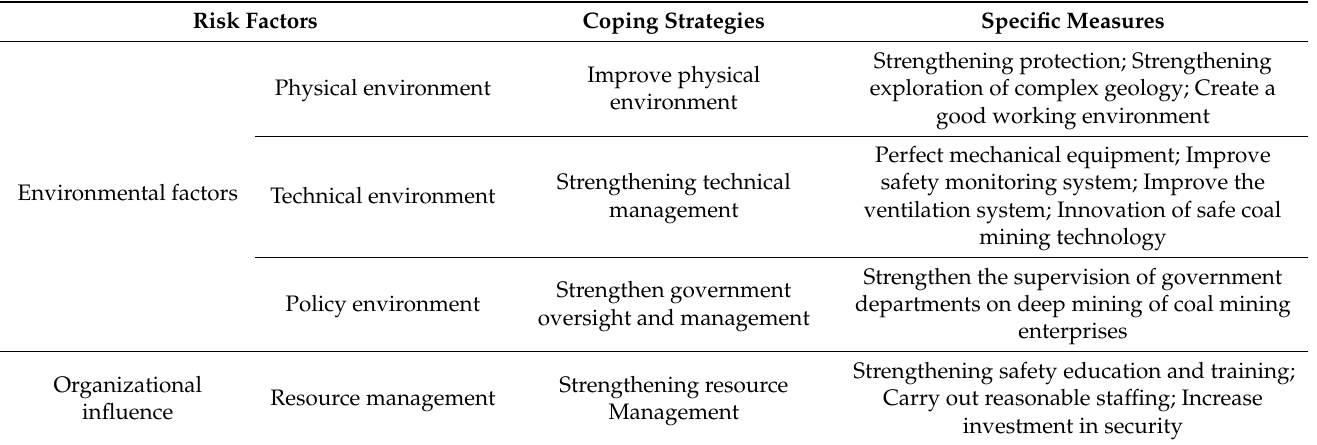
Table 11. Intervention strategies for unsafe behavior of deep coal